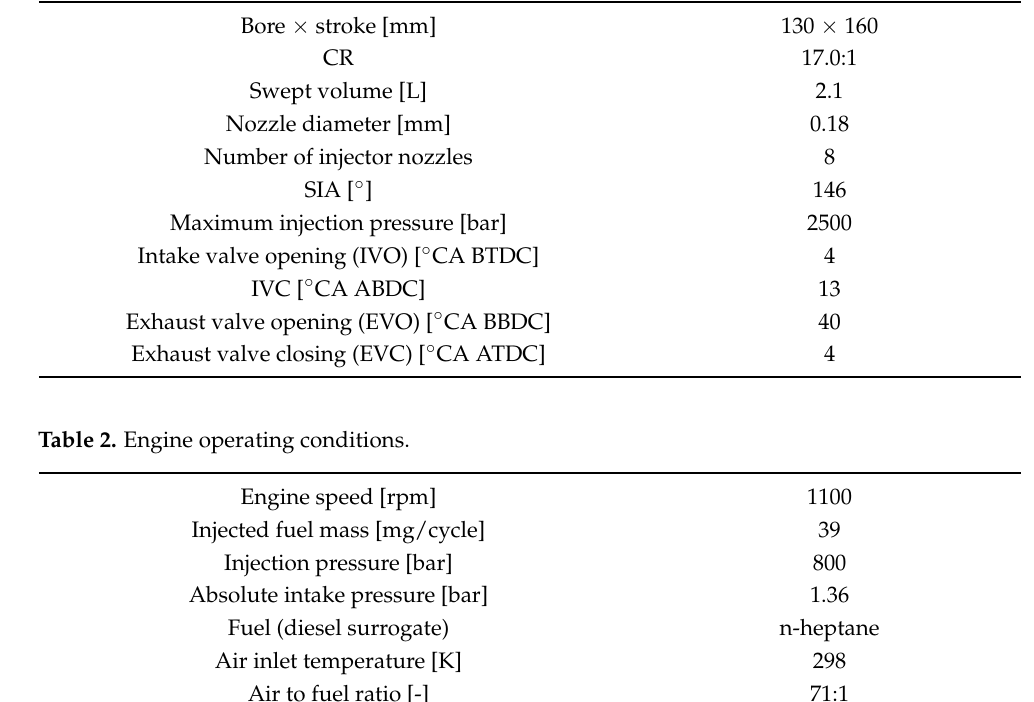
Table 1. Engine technical specifications.